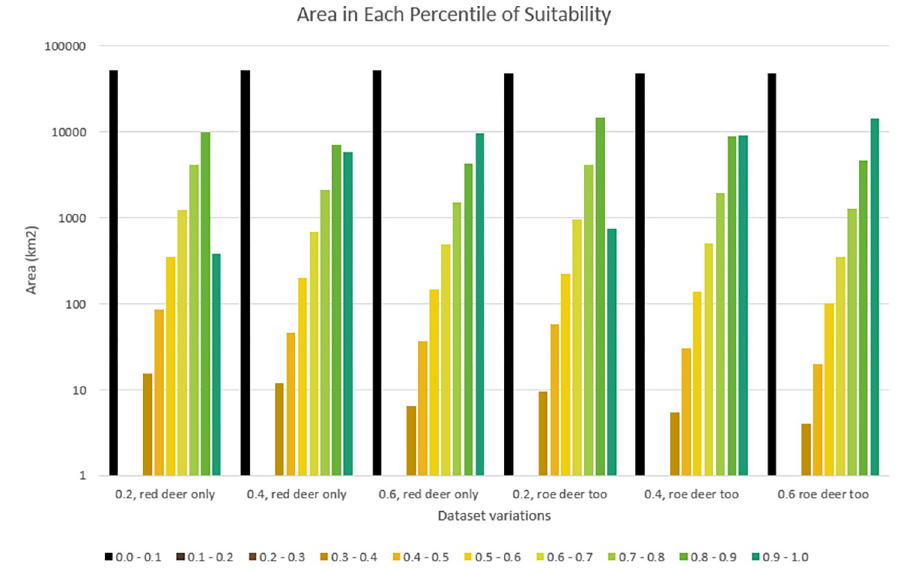
Fig 5. Area of Scotland by suitability class. Area of the Scottish mainland that falls into each of ten classes of suitability under different models (models 1–6 from left to right). Note that the Y-axis uses a logarithmic scale. All models show a similar pattern, with the distribution being highly uneven, and most areas being either completely unsuitable or substantially/completely suitable.